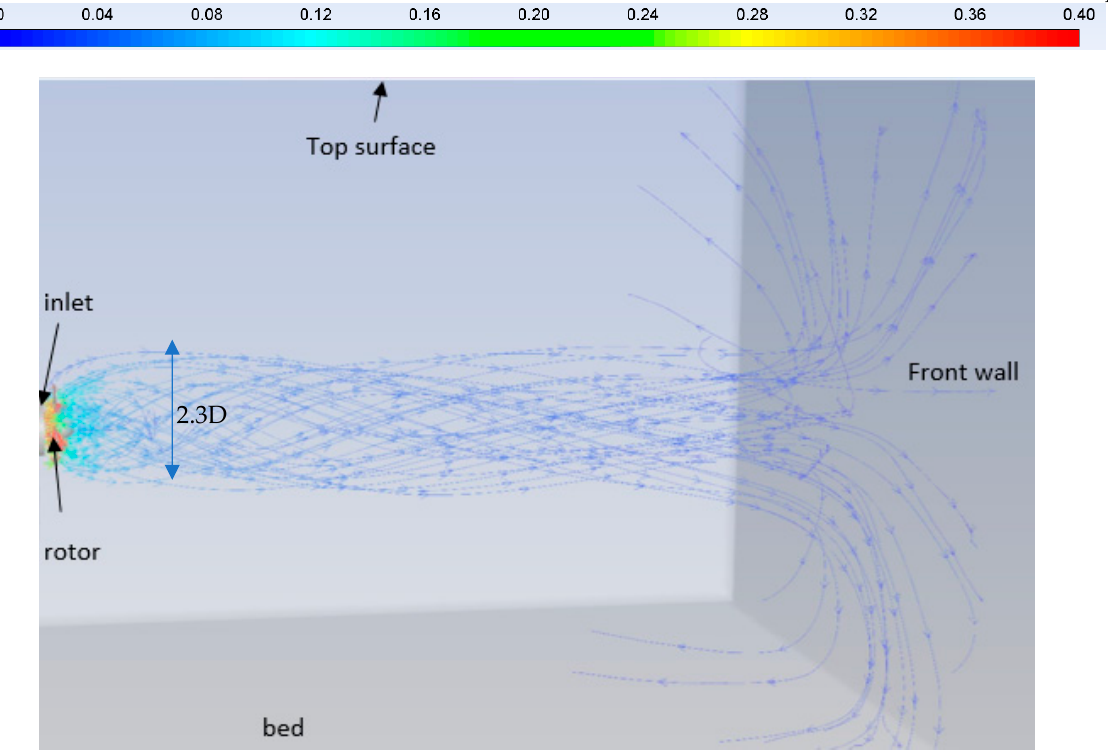
Figure 14. The velocity path-lines at υ av = 30 cm/s and ω = 293.5 rpm.